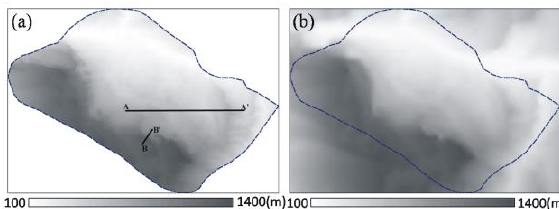
Figure 5. Two DEM images in Yangjiao region, Chongqing: (a) LiDAR DEM and (b) SRTM DEM.